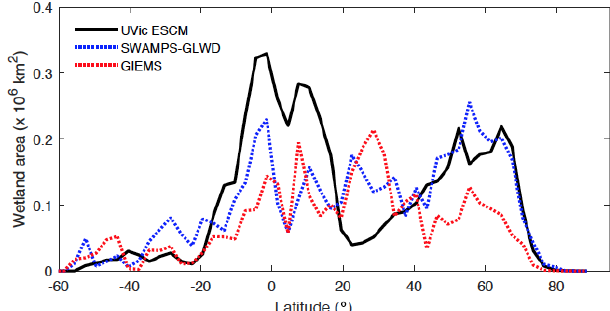
Figure 4. Latitudinal distribution of wetland areas simulated by the UVic ESCM over the 2000–2007 period in comparison to two global datasets: GIEMS and SWAMPS-GLWD. The comparison period corresponds to the overlap period for the two datasets. The wetland areas are summed across latitude bins of 3 ◦